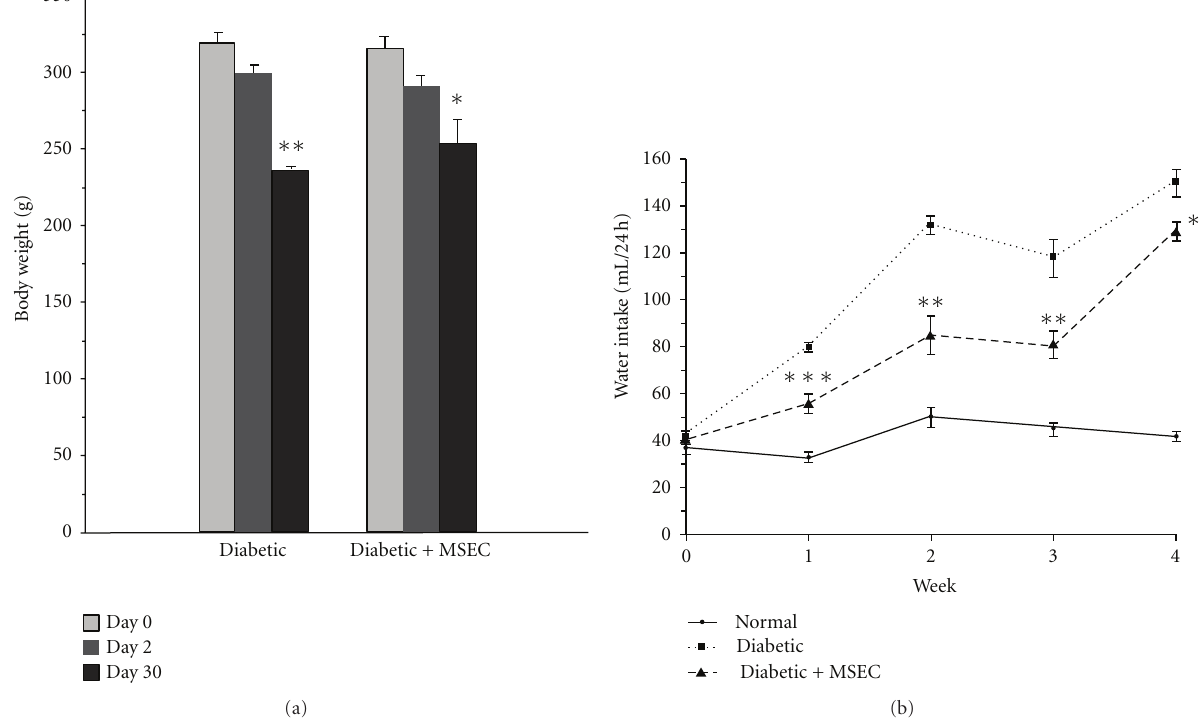
Figure 2: E ff ect of long-term administration of MSEC on body weight and water intakein diabetic rats. The animals in group of diabetic + MSEC received diet containing 4% (w/w) of MSEC for 1 month. (a): ∗ P < 0 . 01 compared with the corresponding values at day 2 and day 0. ∗∗ P < 0 . 001 compared with the corresponding values at day 2 or day 0. (b): ∗ P < 0 . 001 and P < 0 . 05 compared with the corresponding values of normal and diabetic + MSEC group, respectively. ∗∗ P < 0 . 01 compared with the corresponding values of normal or diabetic + MSEC group. ∗∗∗ P < 0 . 001 compared with the corresponding values of normal or diabetic + MSEC group. The data are expressed as mean ± SEM for seven (body weight) or six (water intake) rats. MSEC: combination of both macerated and Soxhlet extracts (see Table